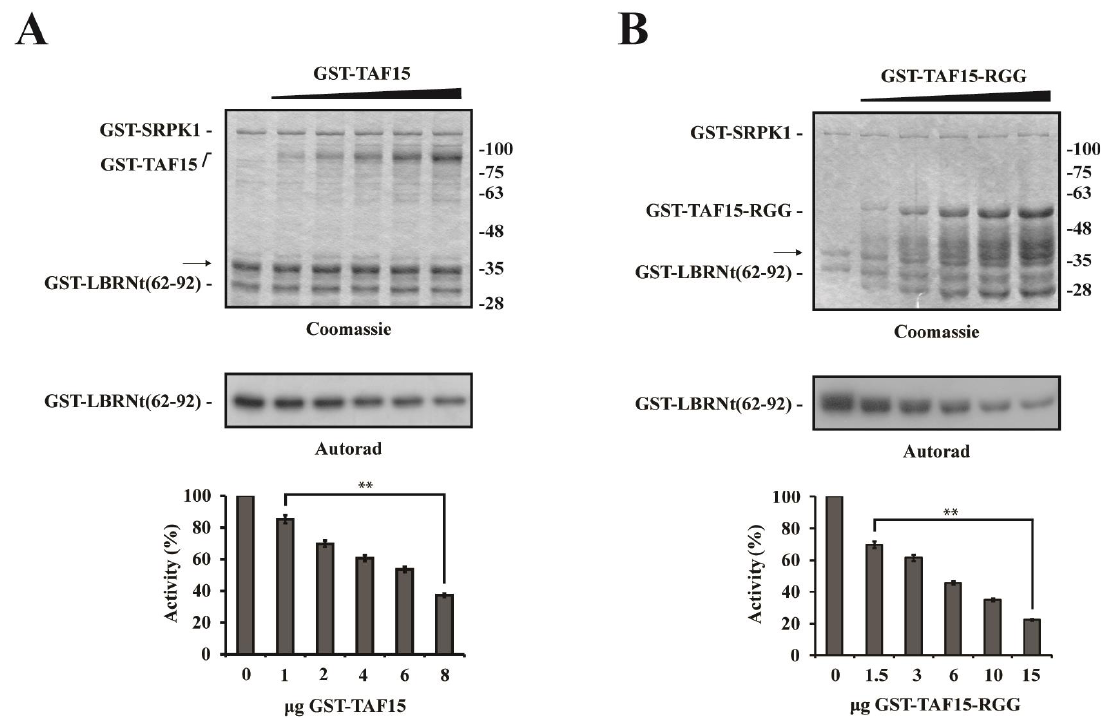
Figure 4. The C-terminal RGG domain of TAF15 inhibits SRPK1 activity. The GST-SRPK1 kinase was incubated with GST – LBRNt(62 – 92 ) and [γ -32P]ATP in the presence of 1, 2, 4, 6, and 8 μg GST-TAF15 ( A ) and 1.5, 3, 6, 10, and 15 μg GST -TAF15-RGG ( B ). The samples were analyzed by SDS-PAGE, Coomassie blue stained (upper panels), and autoradiographed (middle panels, only the respective part of the gel is shown). The band indicated by the arrow represents a GST-SRPK1 degradation product. The full-length GST-TAF15-RGG migrates with an apparent molecular mass of approximately 53 kDa. The lower bands represent degradation products. Phosphorylated bands were excised from the dry gel, and Cherenkof counted (lower panels). Data represent the means ± SE of two independent experiments. P values: ** P = 0.001063 (for GST-TAF15), ** P = 0.00812 (for GST-TAF15-RGG).